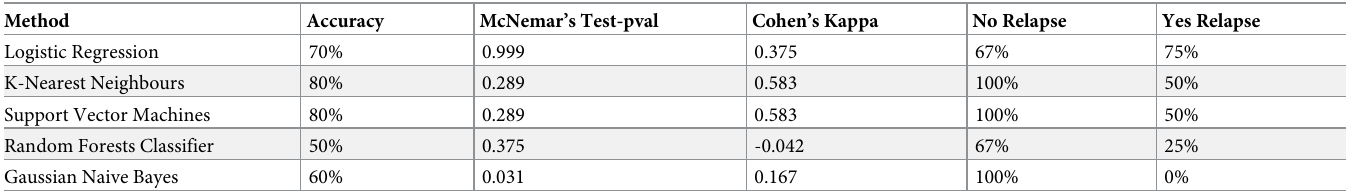
Table 7. Classification analysis performance for various supervised classification algorithms for the prediction of patient relapse based on LV miRNA expression.